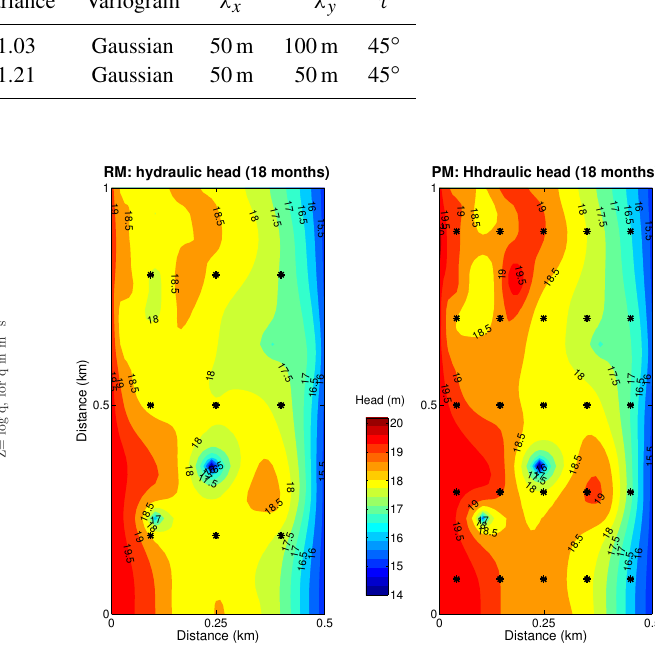
Figure 2. Left panel: daily transient reference pumping rates from wells PW1, PW2, and PW3. Negative values indicate pumping or groundwater that is being removed from the aquifer. Right panel: reference heterogenous spatial recharge values obtained using the sequential Gaussian simulation code (Gómez-Hernández and Jour- nel, 1993) with parameters given in Table 2.